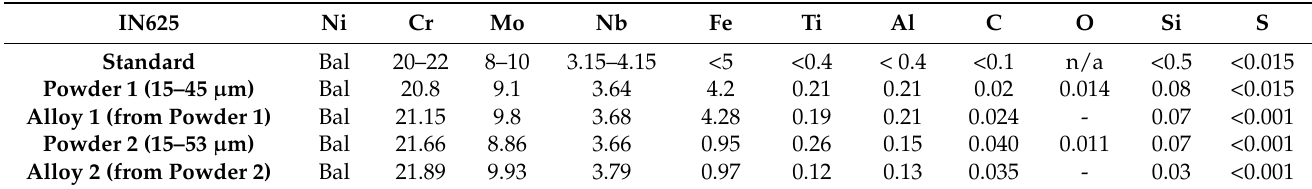
Table 1. Chemical compositions of the IN625 specimens and of standard IN625 alloy (in